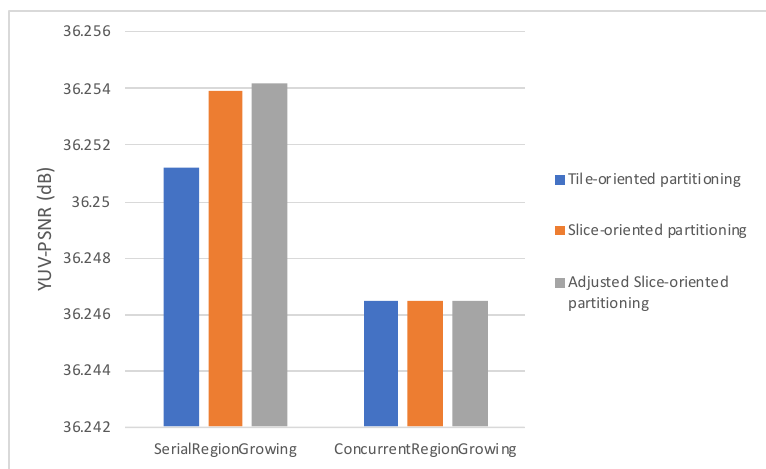
Figure 16. Average YUV-PSNR performance for 7 regions.